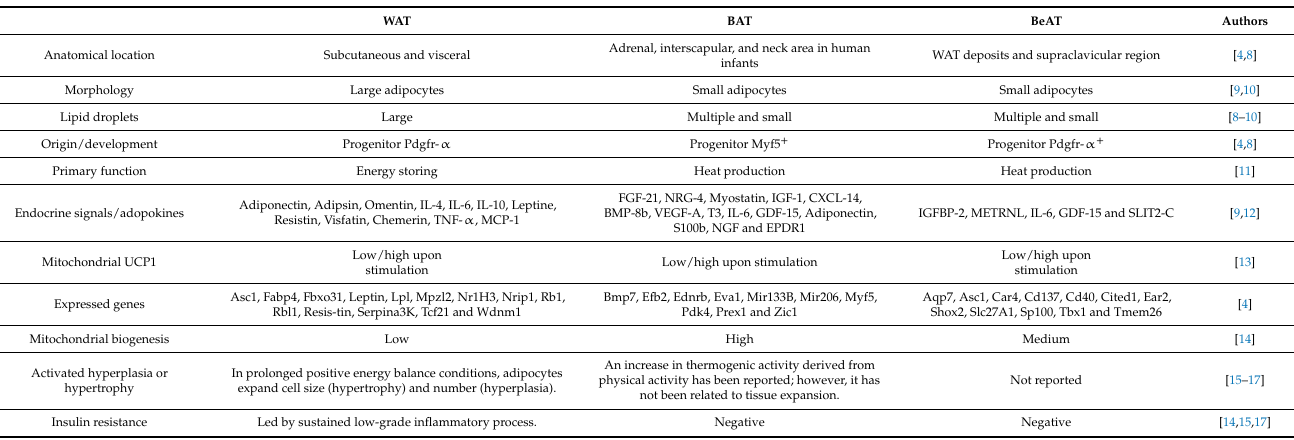
Table 1. Characteristics and differences among white (WAT), brown (TAB) and beige (BeAT) adi- pose